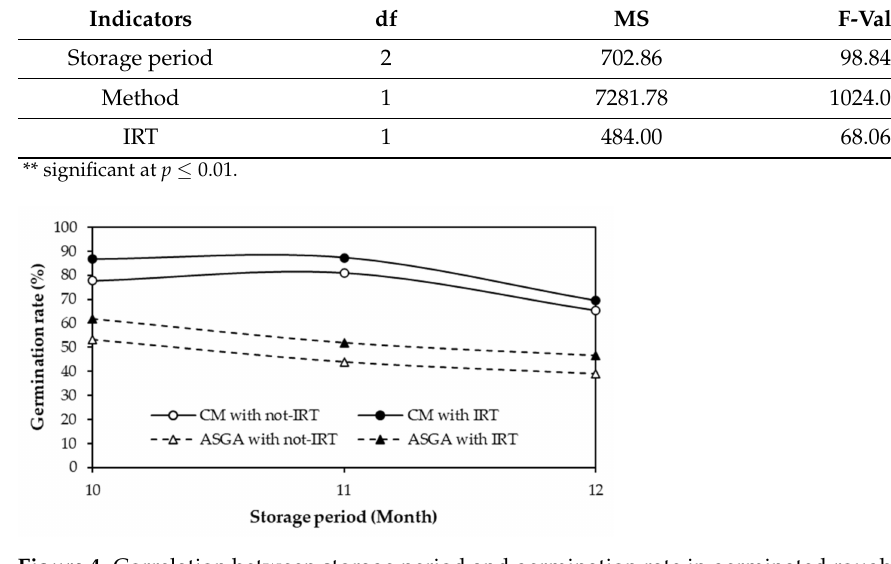
Figure 4. Correlation between storage period and germination rate in germinated rough rice (GRR) using the conventional method (CM) with stimulation and with no stimulation via infrared radiation treatment